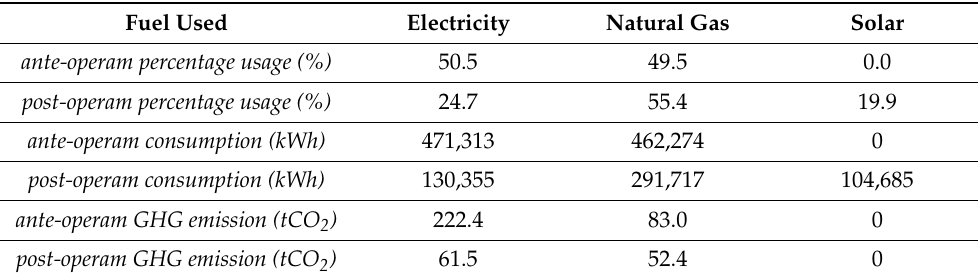
Table 1. GHG emissions for ante- and post-operam scenarios. Fuel Used Electricity Natural